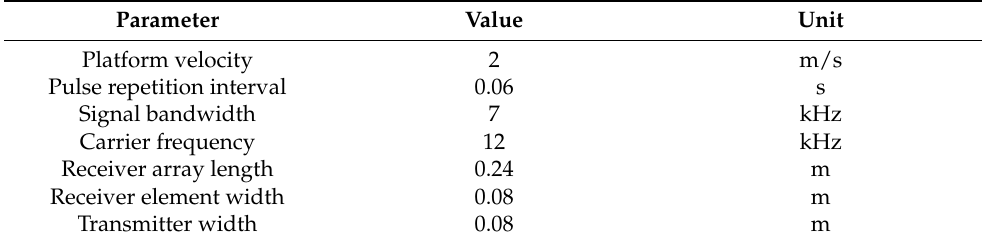
Table 8. Real SAS parameters with a wide-bandwidth signal.